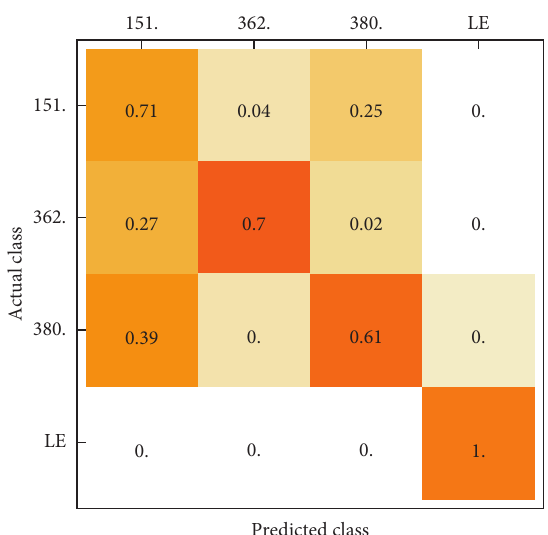
Figure 12: An average confusion matrix calculated during cross- validation using the SVM classifier. The accuracy is relatively poor at 61%, but this can be attributed to the lack of training data and train